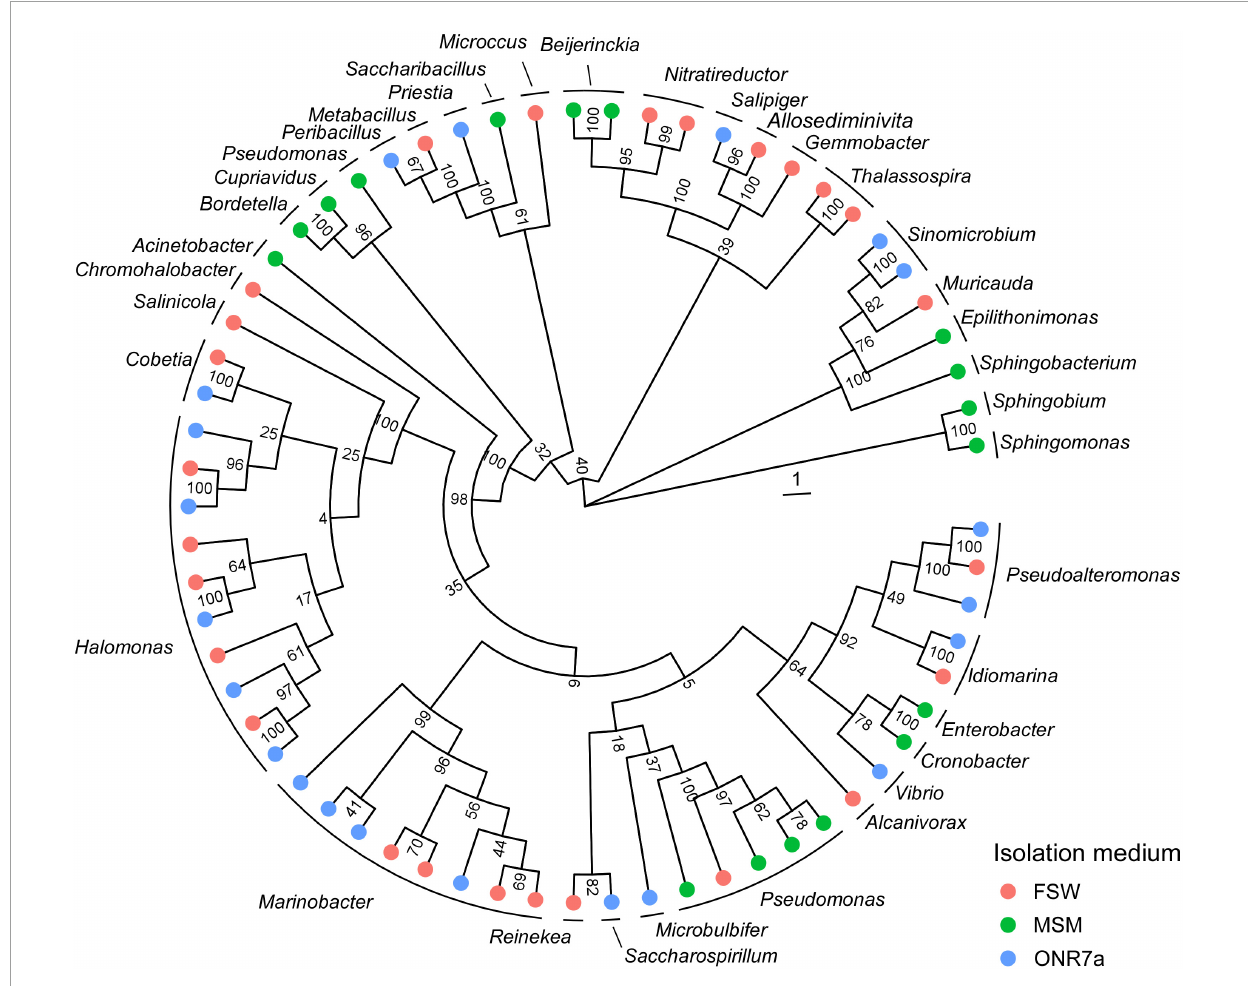
FIGURE1 Phylogenetic tree of cultivable bacteria harbored by mangrove oligotrophic sediments. The colors on the outer ring refer to the medium used for the isolation, namely, FSW (red), MSM (green), and ONR7a (blue). A representative sequence for each ITS haplotype is included (see Supplementary Table 1 for the full